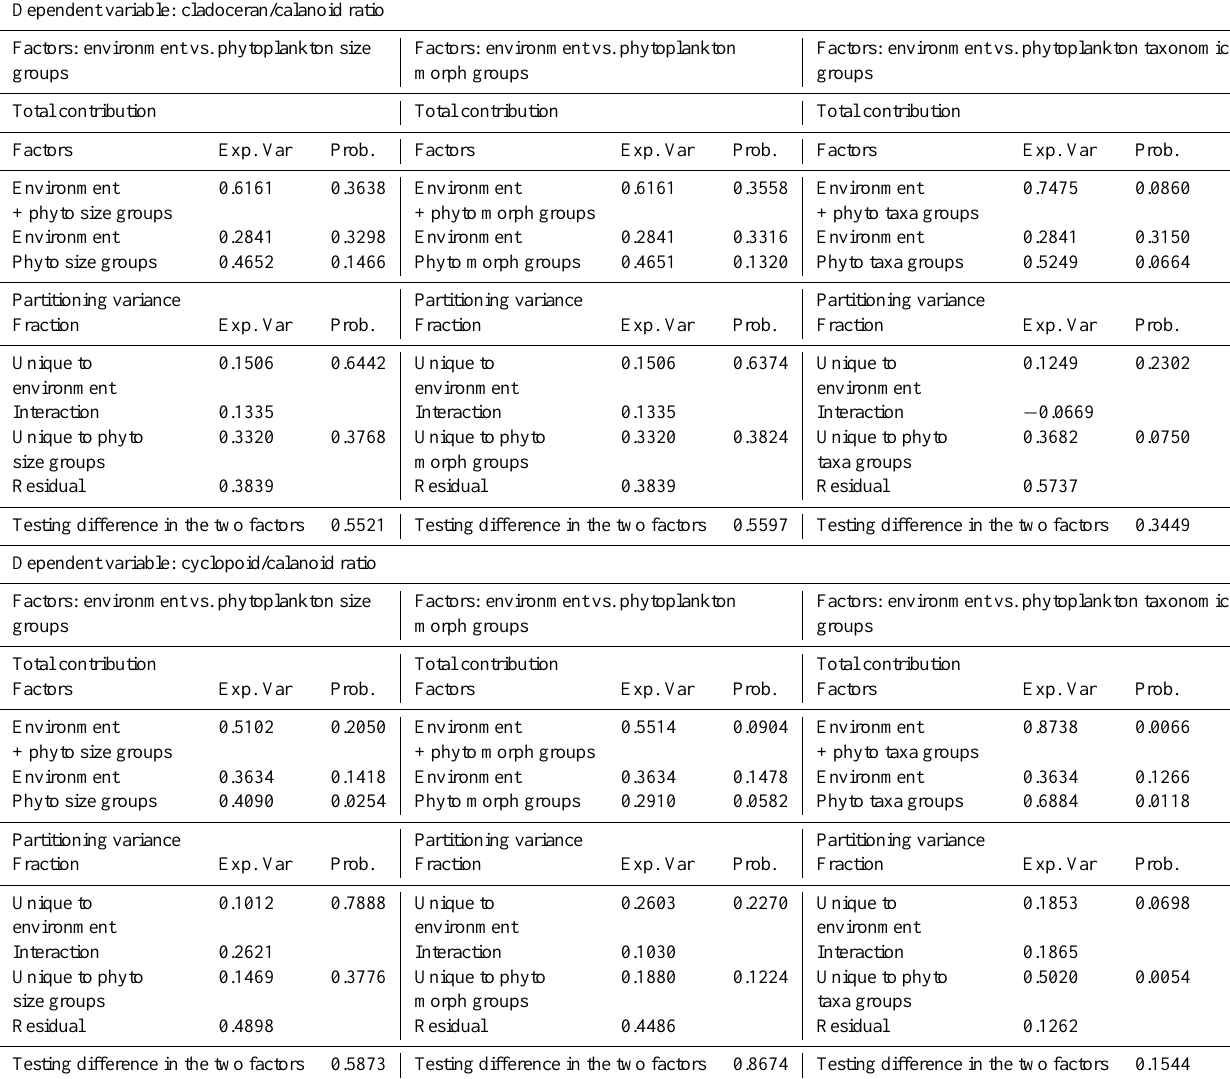
Table 6. Results of variance partition to investigate the relative contribution of environmental and phytoplankton matrices in explaining the ratio of cladoceran/calanoid and